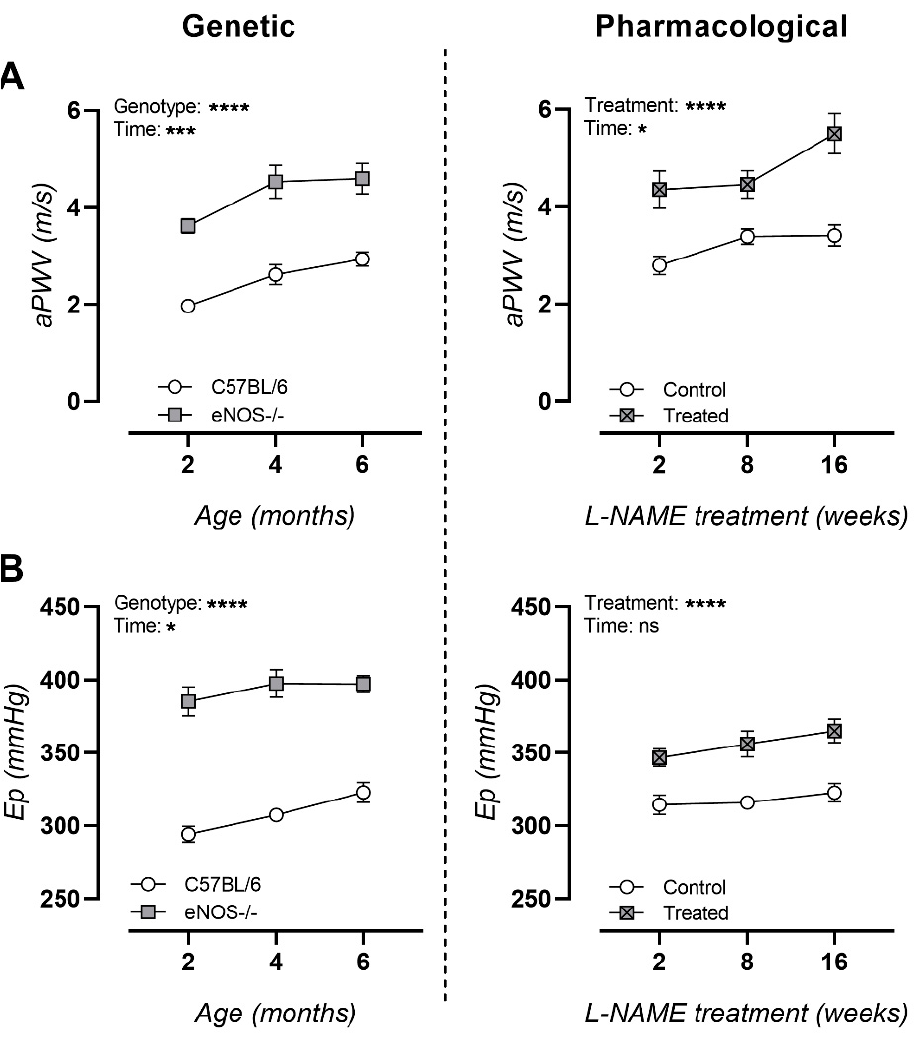
Figure 3. Longitudinal arterial stiffness measurements in genetic and pharmacologically manipulated murine models of NO dysfunction. ( A ) In vivo measurements of aPWV and ( B ) ex vivo measurements of elastic Peterson modulus (Ep) for genetic (eNOS − / − , left column) and pharmacologically treated (L-NAME, right column) animals. Factorial ANOVA for the factors genotype/treatment and time; * p < 0.05, *** p < 0.002, **** p < 0.0002. Data are presented as mean ± SEM.